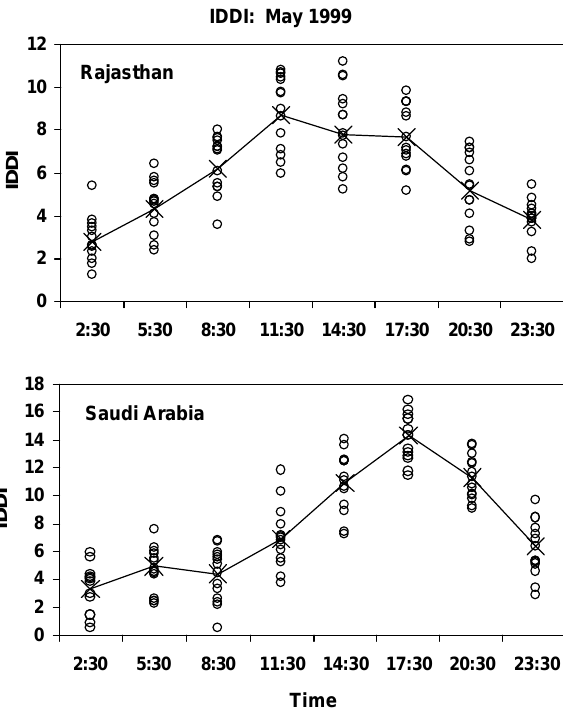
Fig. 16. Nighttime image of dust event. The IDDI is in K. 16. Nighttime image of dust event. Here IDDI is in K.